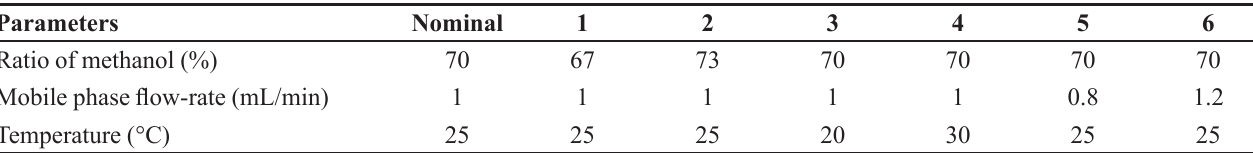
TABLE II - Parameters and conditions proposed to evaluate robustness